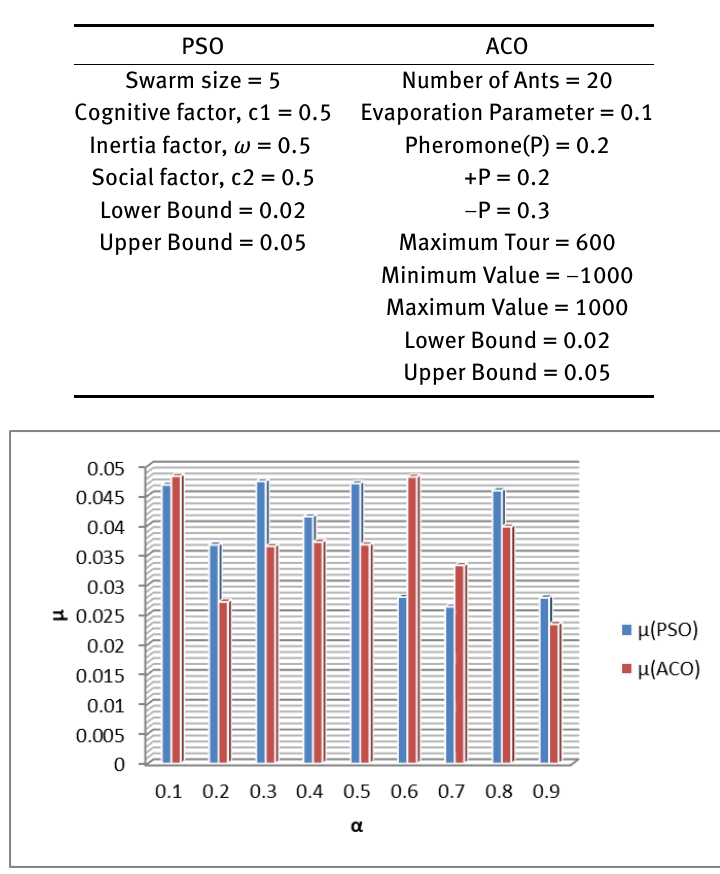
Figure 8: Values of µ calculated with the help of ACO and